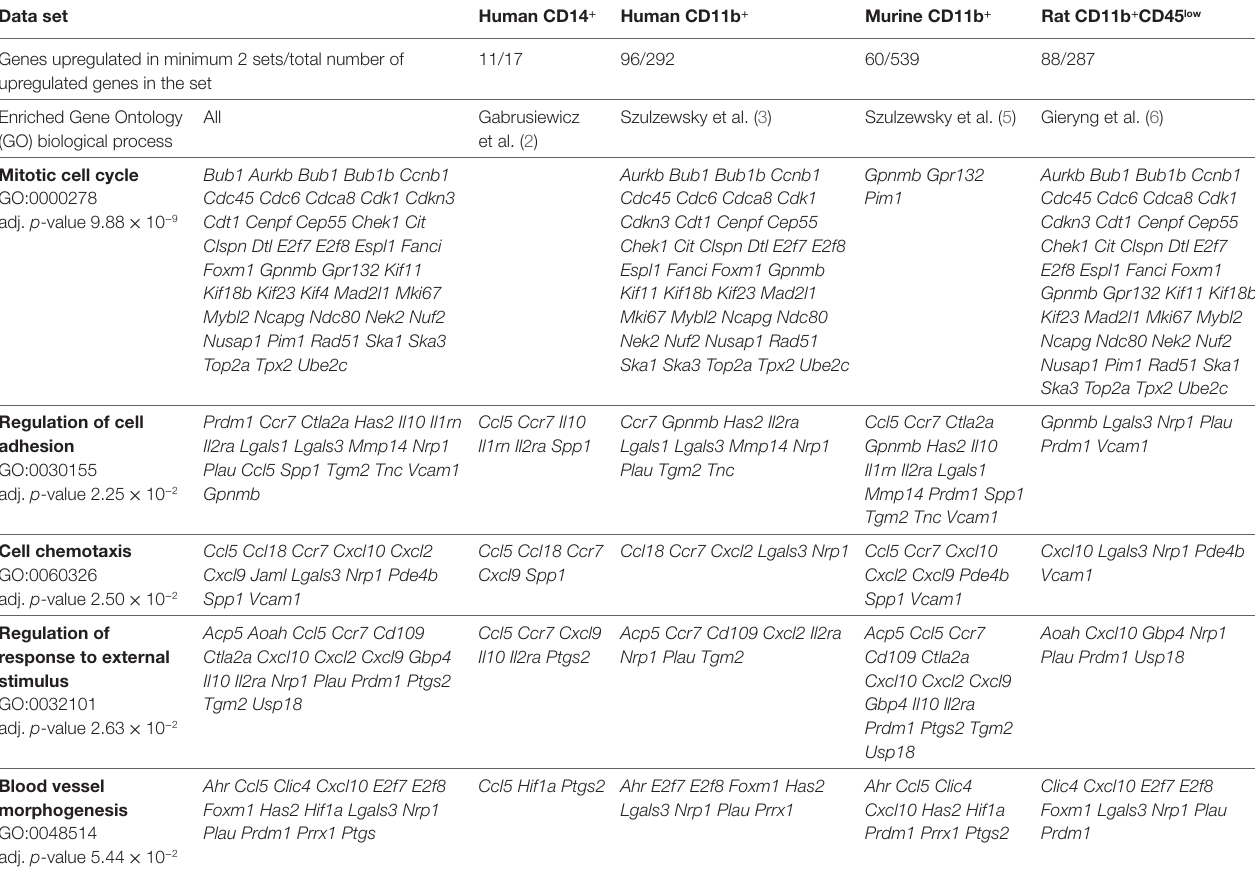
TaBle 2 | Co-occurrence of genes from the same functional groups across all data sets. Data